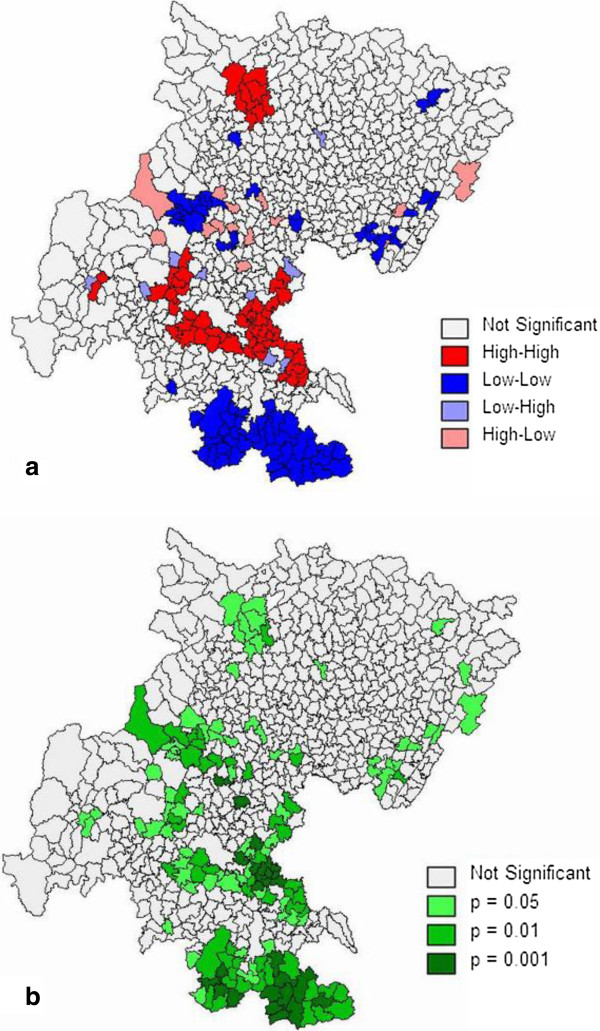
LISA map of CHD Prevalence. (a) is the LISA cluster map of CHD prevalence, (b) is the LISA significance map of CHD prevalence.